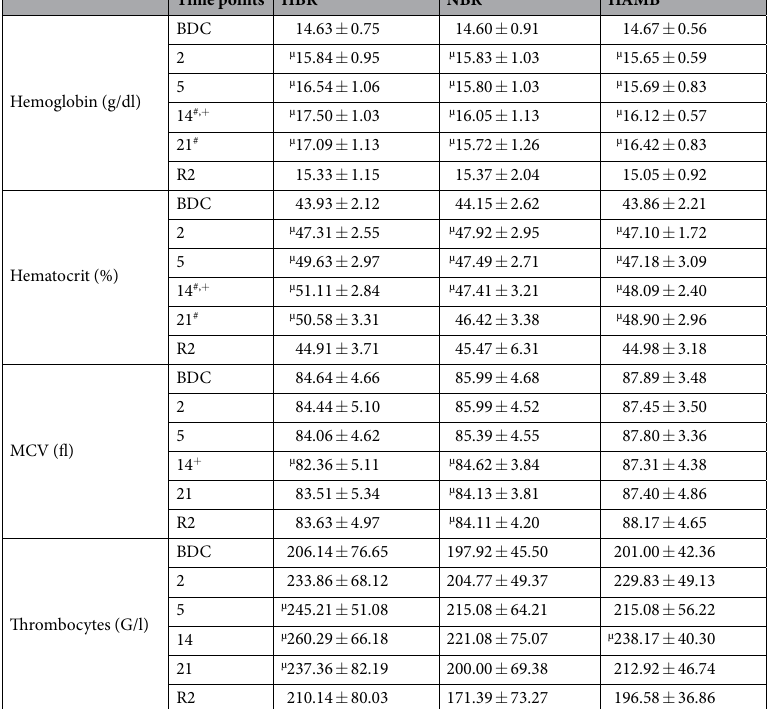
Table 1. Cellular blood parameters; data are means ± SD; MCV = mean corpuscular volume; HBR = hypoxic bed rest (n = 14); NBR = normoxic bed rest (n = 13); HAMB = hypoxic ambulation (n = 12); BDC = Baseline Data Collection; R2 = 2 days after the end of condition; # Significant difference between HBR and NBR; + Significant difference between HAMB and HBR; * Significant difference between HAMB and NBR at the respective time points; µ Significant difference vs. BDC in the respective group (p < 0.05).